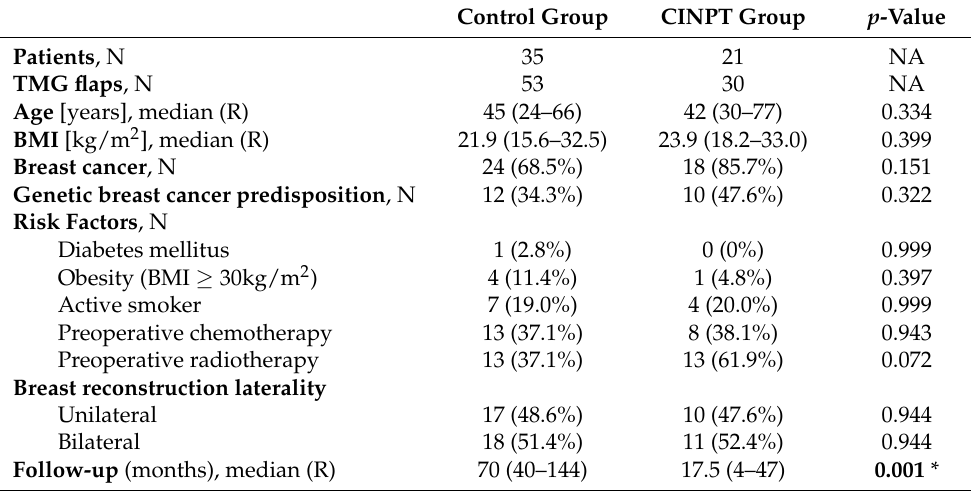
Table 1. Patient characteristics.